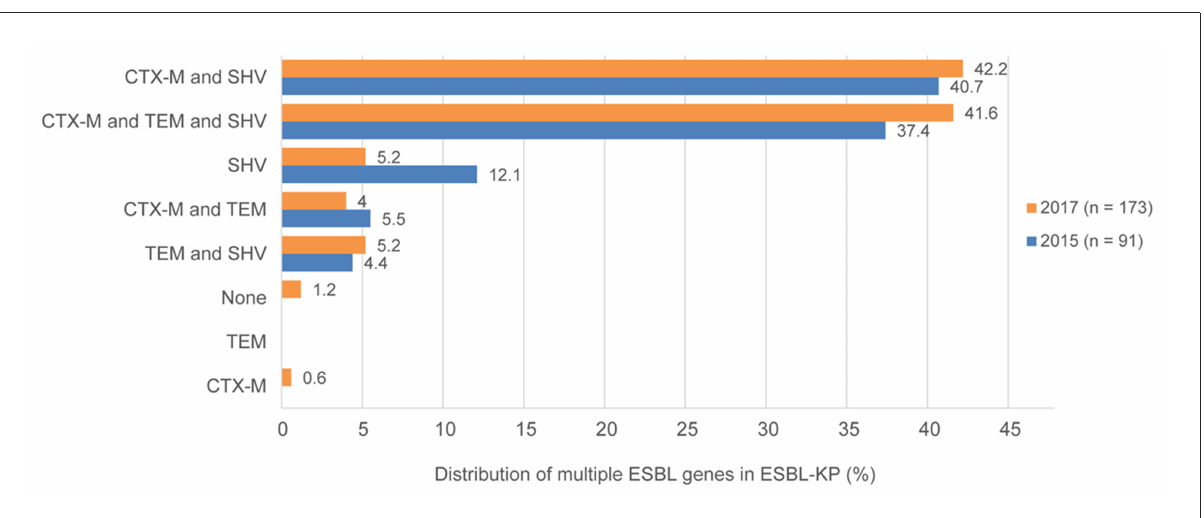
FIGURE3 Existence and proportions of multiple ESBL genes for ESBLs-producing K. pneumoniae in 2015 and 2017.